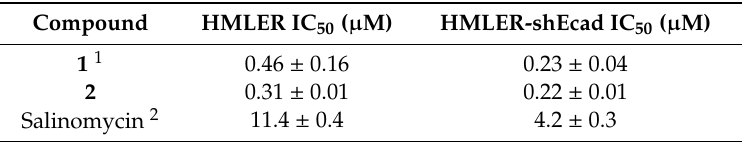
Table 1. IC 50 values of 1 , 2 , and salinomycin against human bulk breast cancer / CSC-depleted cells (HMLER) and breast CSC-enriched cells (HMLER-shEcad) cells determined after 72 h incubation (mean of three independent experiments ± SD).